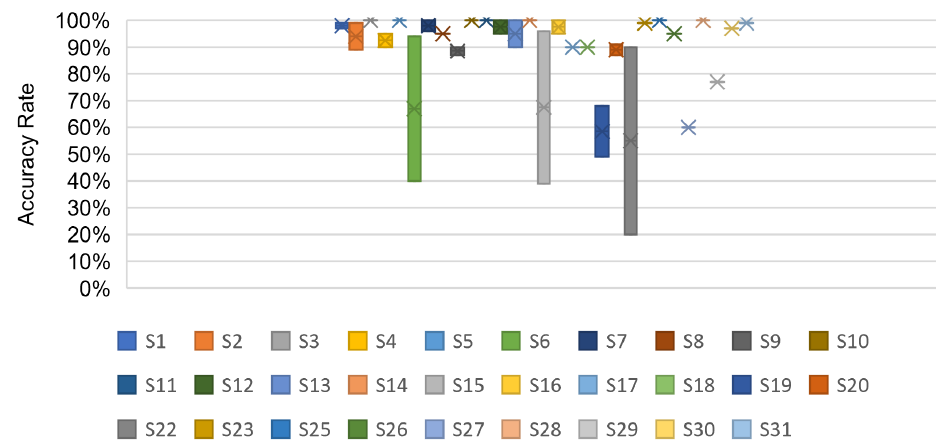
Figure 8. The performance results of selected